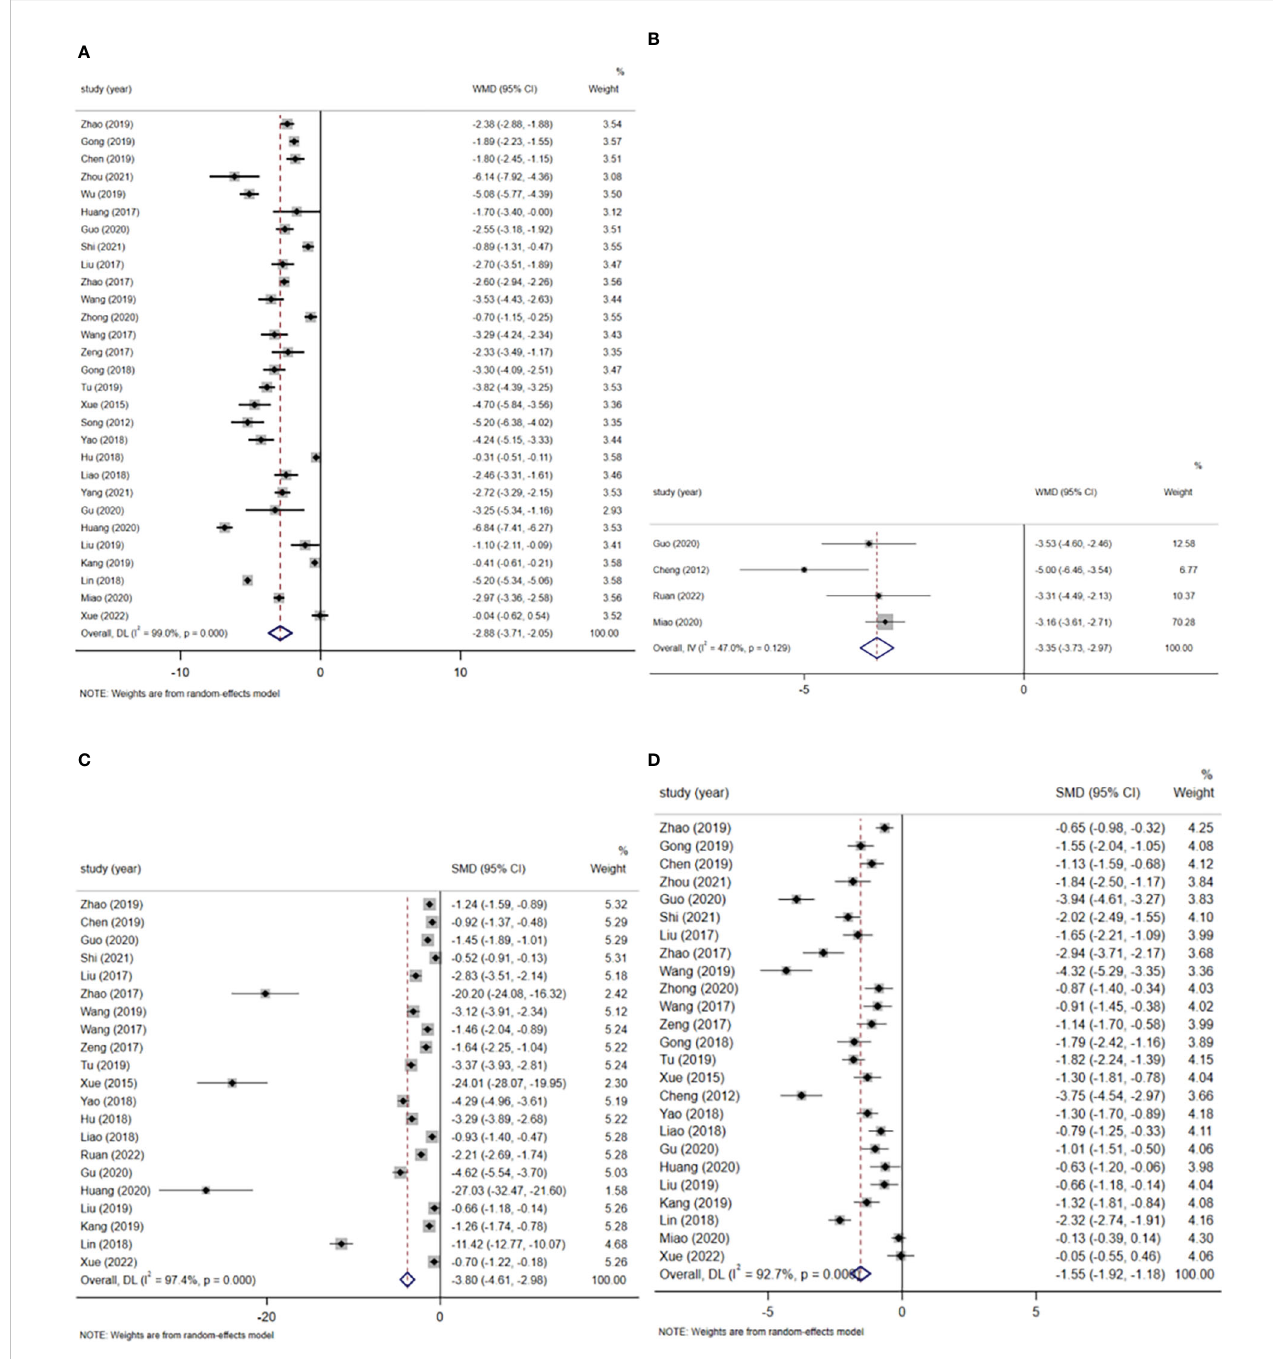
group. A random-effects model summary showed that the ERAS group signi fi cantly moved patients out of bed earlier after surgery compared to the routine care group (SMD=-3.80, 95% CI: -4.61 to -2.98, p<0.001, I 2 = 97.4%) (Figure 3C). Subgroup analysis by surgical approach showed that ERAS signi fi cantly earlier postoperative bed mobility in both robot- assisted laparoscopic surgery and laparoscopic surgery (robot-assisted laparoscopic surgery: SMD=-3.91, 95% CI: -5.21 to -2.61, p<0.001, I 2 = 82.2%; laparoscopic surgery: SMD=-4.33, 95% CI. -5.33 to -3.33, p<0.001, I 2 = 97.7%) (Figure 2 in Supplementary Data Sheet